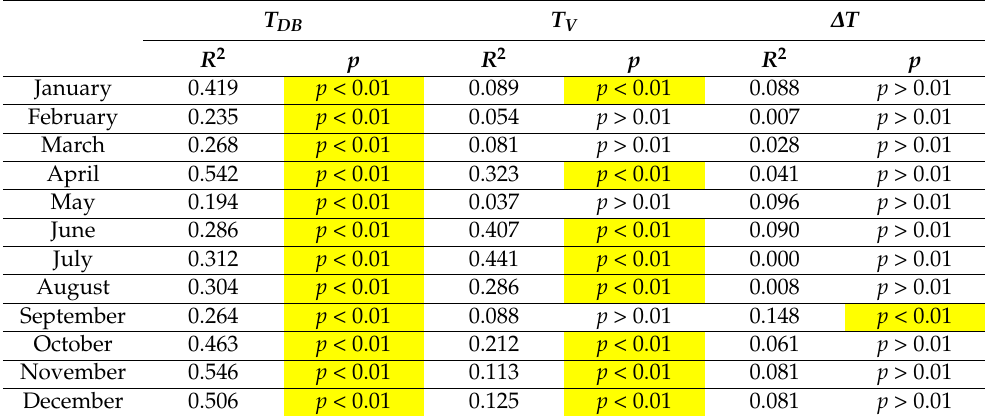
Table 5. Values of the square of the correlation coefficient, R 2 , and the probability of the Mann– Kendall test, p , for the series of mean monthly water temperatures of Drava Botovo, T DB , the series of mean monthly air temperatures of Varaždin, T V , and the series of their differences, ∆ T = T DB − T V , from 1969–2021.